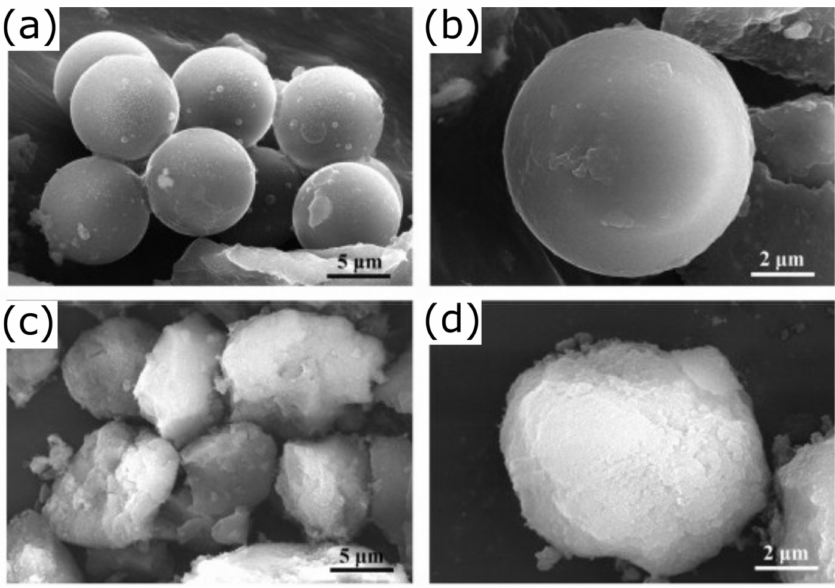
Figure 12. SEM micrographs of n -octadecane/sodium silicate mass ratios and pH values: ( a , b ) 50/50 and pH between 2.95 and 3.05; ( c , d ) 50/50 and pH between 7 and 8